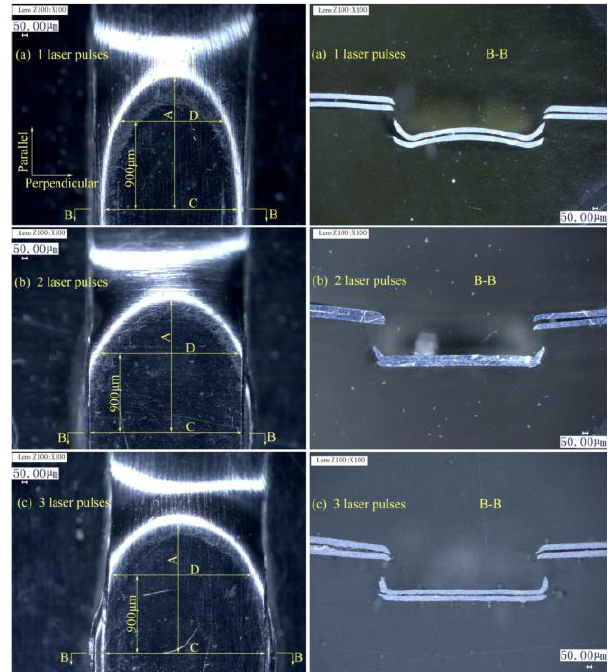
Figure 7. Lower foil side-view and B–B section of preliminary joints with three different numbers of laser pulses on the upper foil side: ( a ) 1 pulse; ( b ) 2 pulses; and ( c ) 3 pulses.